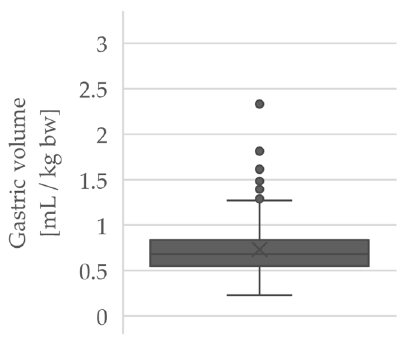
Figure 1. Measurement results of GRV, calculated according to Bouvet et al. (formula for measure- ments in supine position) [14] in mL/kg bw.